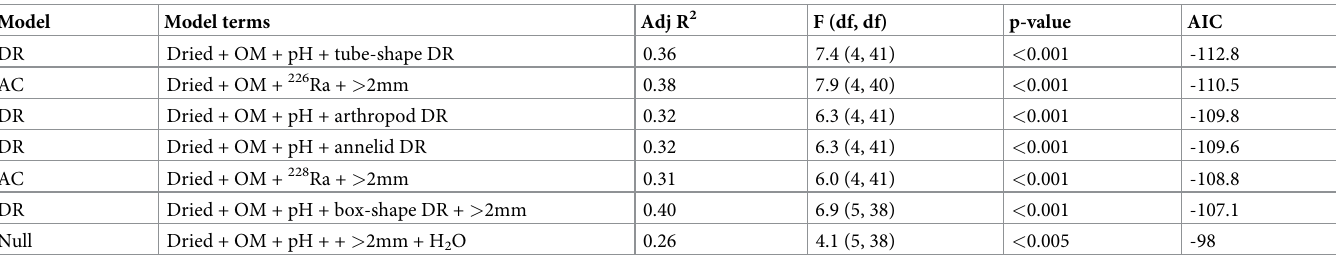
Table 5. Comparison of statistical null models (Null), activity concentration models (AC) and dose rate models (DR).